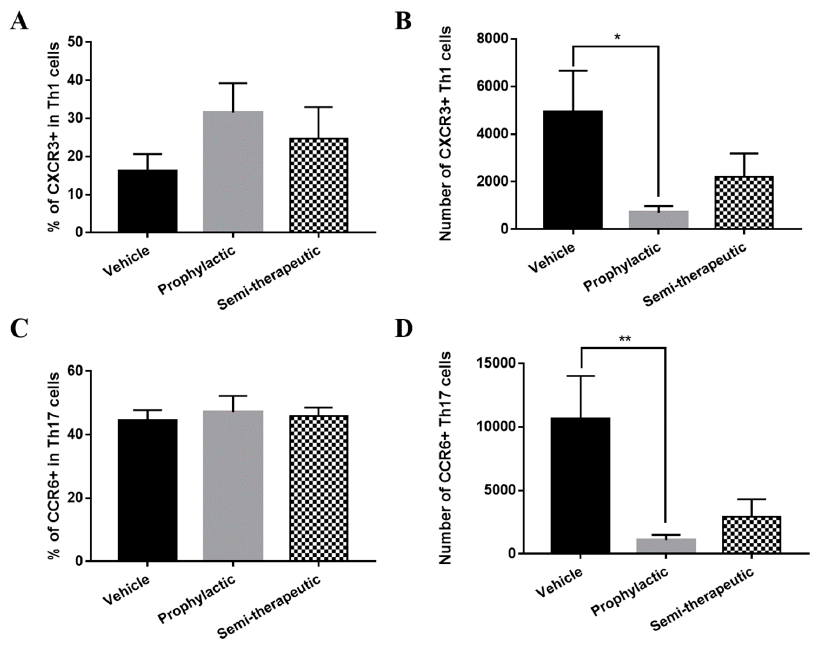
Figure 5. GLP-1 RA dulaglutide treatment inefficiently affects the chemotactic abilities of encephalitogenic Th1 as well as Th17 cells into the CNS. Frequency ( A and C ) and absolute number ( B and D ) of CXCR3+ Th1 ( A , B ) and CCR6+ Th17 ( C , D ) cells in CNS of EAE mice, respectively. EAE mice were treated with three different regimens, including prophylactic (gray bar), semi-therapeutic (dotted bar), and vehicle control (black bar) treatments. Mononuclear cells were isolated from CNS of MOG-immunized mice at day 14 after EAE induction. CXCR3 was represented as a chemo-attractive receptor for Th1 cells; nevertheless, CCR6 was representative of the chemo-attractant receptor for Th17 cells. Cells were verified by the analysis of flow cytometry. The data are representative of three independent experiments. All data for frequency and cell number were presented as mean ± SEM from, at least, 6 mice in each group. *, p < 0.05 and **, p < 0.01 by the non-parametric Kruskal–Wallis test followed by post-hoc analysis, Dunn`s multiple comparisons